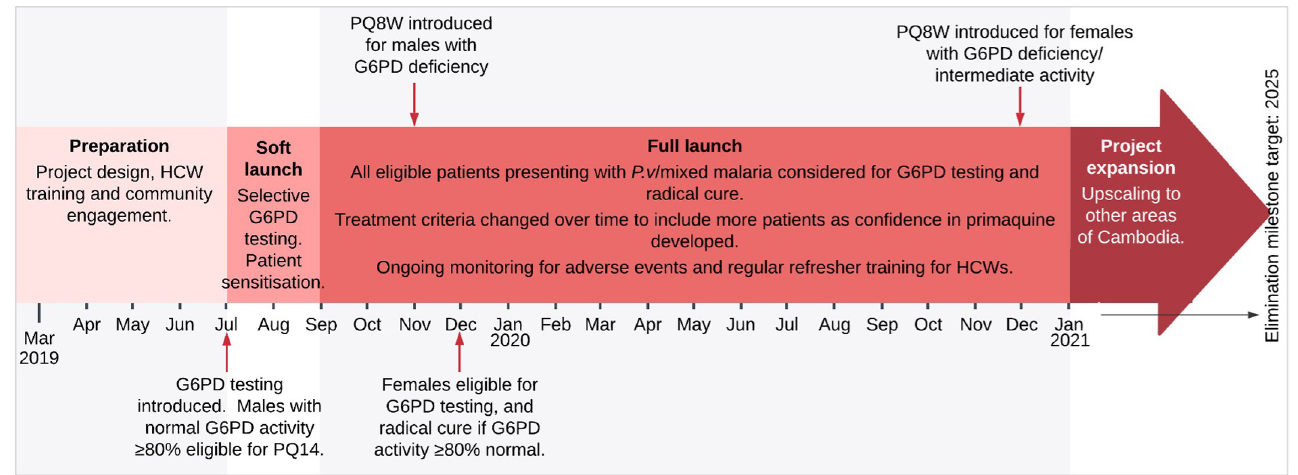
Fig 3. Timeline of implementation of the G6PD testing and radical cure programme. G6PD = glucose-6-phosphate dehydrogenase. P . v = Plasmodium vivax . PQ14 = 14-day primaquine course. PQ8W = 8-week primaquine course. HCW = healthcare worker (including village malaria workers and health centre staff).